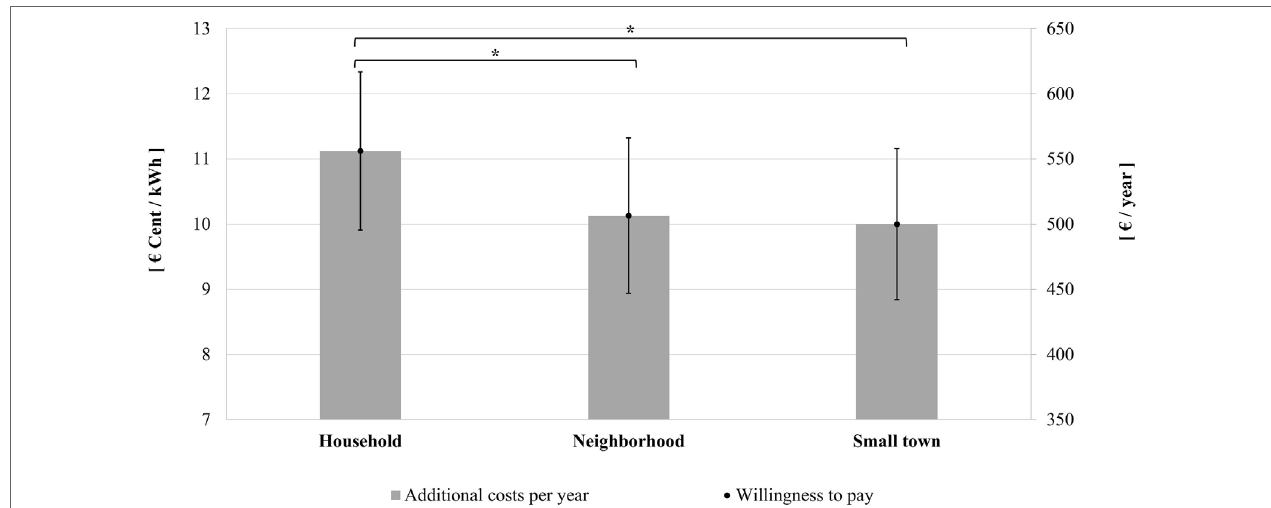
FigUre 5 | Mean values in EUR cent per kWh and EUR per year for the three supply scenarios; left y -axis: additional costs per kWh; right y -axis: resulting additional costs per year for an annual consumption of 5,000 kWh. A repeated measures ANOVA revealed a significant main effect, F (2, 334) = 8.97, p < 0.001, η p2 0 051. = . Pairwise comparison revealed that the willingness to pay more were higher in the Household Scenario than in the Neighborhood Scenario ( p = 0.003) and than in the Small Town Scenario ( p = 0.002), but the difference between the two latter scenarios was not significant ( p = 1). Error bars depict the 95% confidence intervals. N = 168 (100 females). * p ≤ 0.0125.